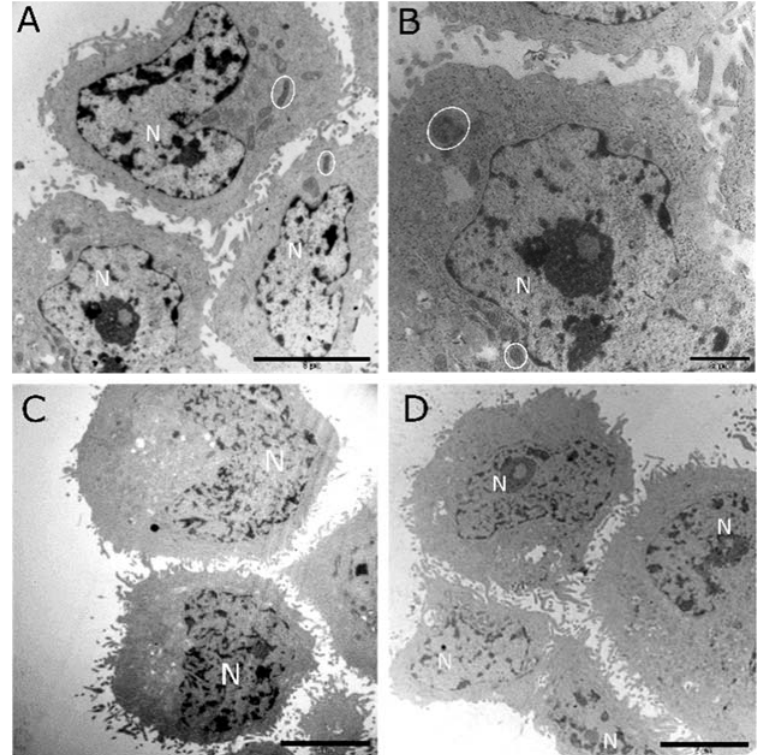
Figure 8. Transmission electron micrographs of the CaSki, control, and low ‐ dose cholecalciferol ‐ treated cultures. Both the medium control ( A ) and solvent control ( B ) showed healthy cells with intact cell and nuclear membranes and clearly defined nuclei (N). Mitochondria (encircled) did not show abnormal morphology. Low ‐ dose cholecalciferol treatments of CaSki cultures of 10 ng/mL ( C ) and 40 ng/mL ( D ) did not show morphological features consistent with cell death. Scale bar: ( A , C ) = 5 μ m and ( B , D ) = 2 μ m.